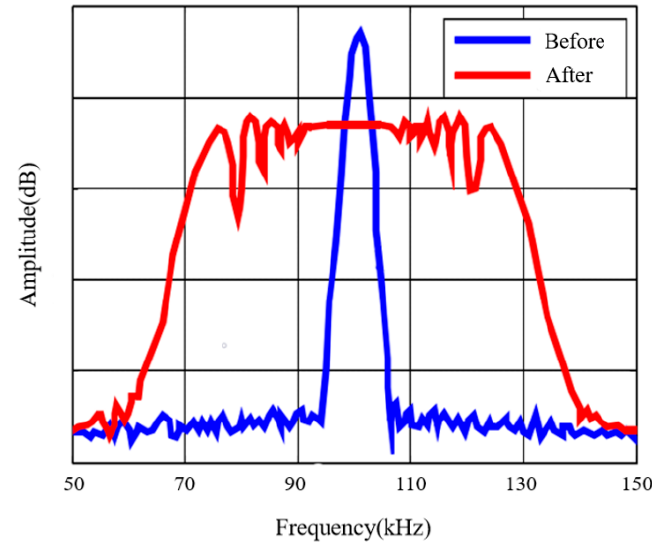
Figure 21. Schematic diagram of the spread spectrum at the switching frequency of 100 kHz.